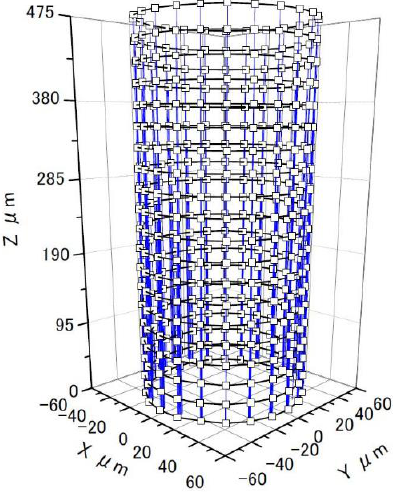
Figure 19. Profile of φ100-µm micro-hole measured by the proposed measurement system.